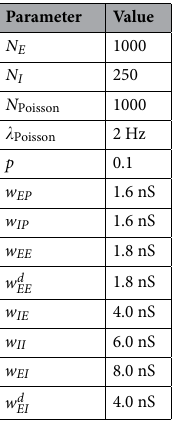
Table 1. Parameters of the